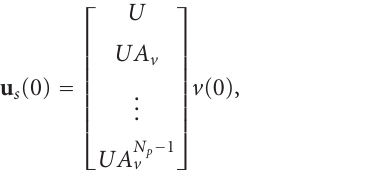
supply voltage returns to its starting value, but the (new) load demand remains. Although the load demand is still higher than its initial value, the u s required will just be within the bounds of ± 1, thus leaving the saturation region to return to the linear region. So, in short, u s is expected to experience “ linear → slightly saturated → deeply saturated → linear but nearly saturated ” in this simulation